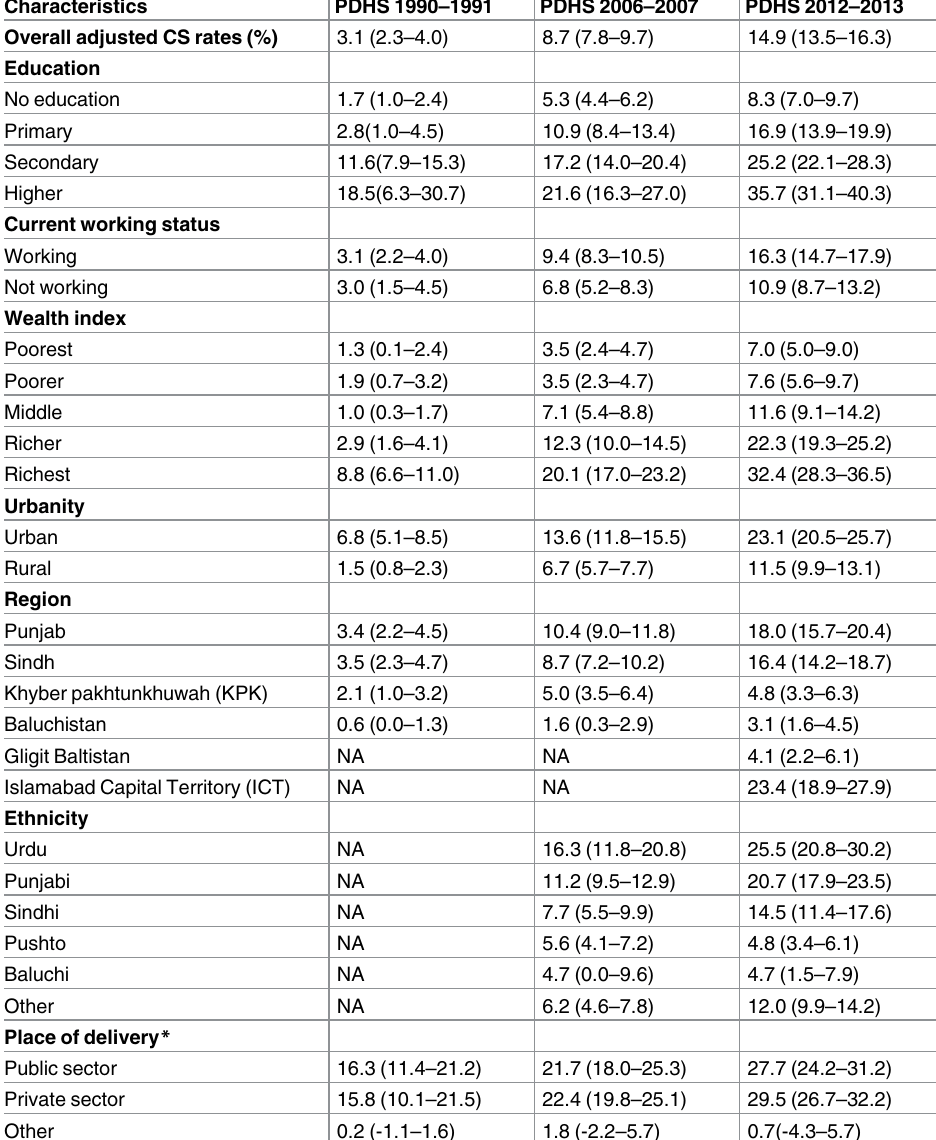
Table 3. Maternal age- and parity-adjusted cesareansection (CS) rates (%) from the Pakistan Demo- graphic and Health Surveys(PDHS) in 1990–1991,2006–2007, and 2012–2013.